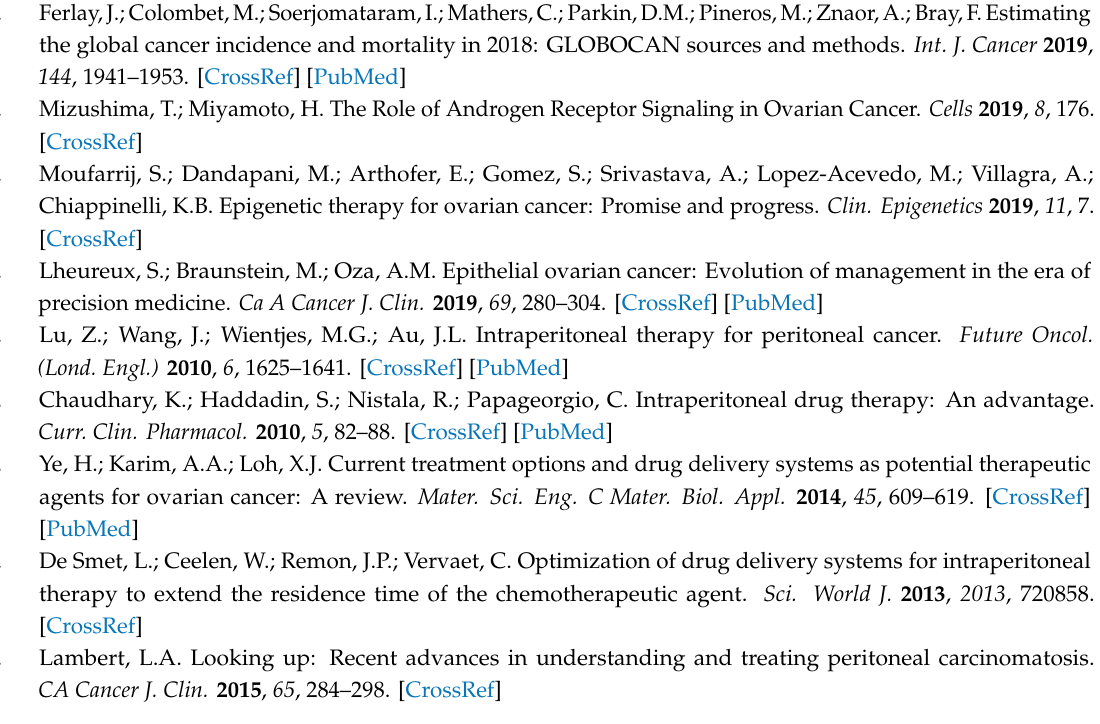
Figure S1: DSC thermograms of pure CBD, raw PLGA, CBD + PLGA physical mixture, unloaded and CBD-loaded nanoparticles. Figure S2: Antiproliferative activity of CBD in solution on SKOV-3 cells over a period of 96 h ( n = 4). Figure S3: Images of SKOV-3 cells treated with cell culture medium (control), PTX (100 nM) or CBDsol (40 µ M) for 12 h Magnification: